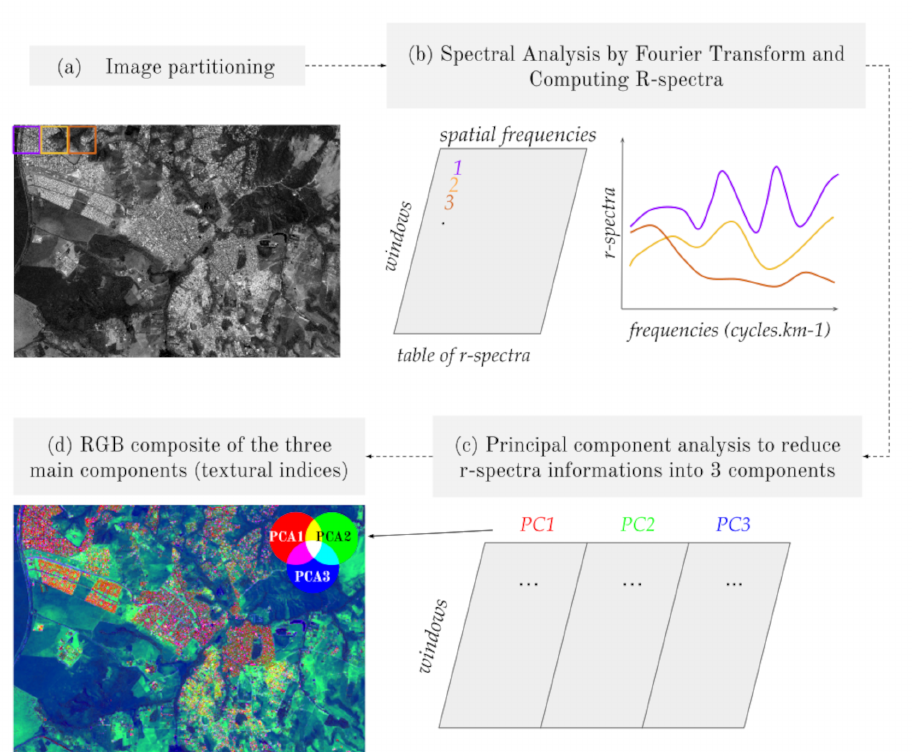
Figure 3. Simplified methodological framework of the FOTOTEX algorithm, divided in four steps ( a ) image partitioning, ( b ) spectral analysis by Fourier transform and R-spectra computation, ( c ) Principal Component Analysis and ( d ) RGB composite of the three main components (textural indices). These steps will be described in detail in the method section